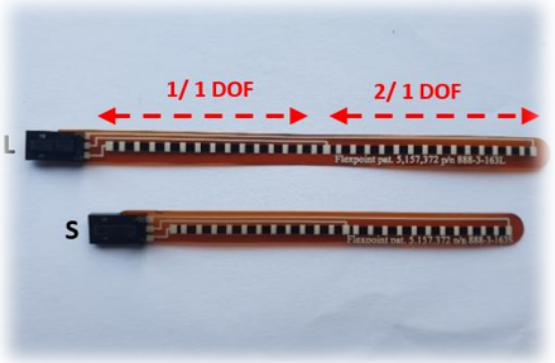
Figure 5. Flexpoint 2-in-1 sensor.